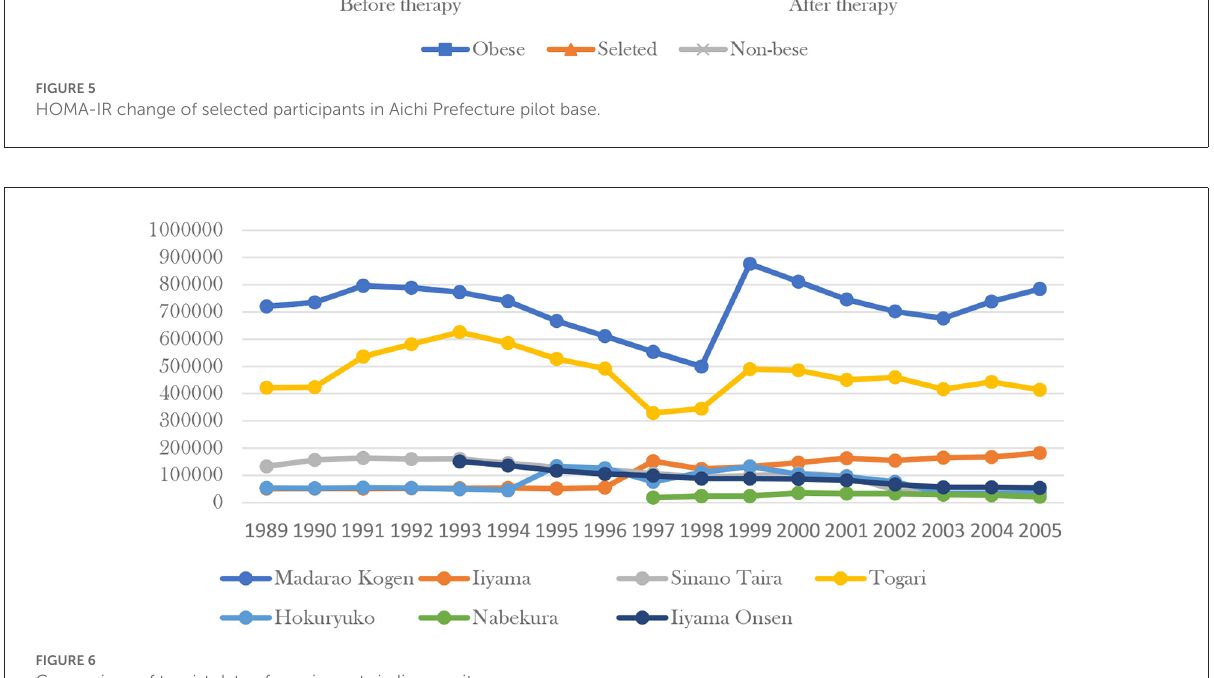
FIGURE6 Comparison of tourist data of scenic spots in Iiyama